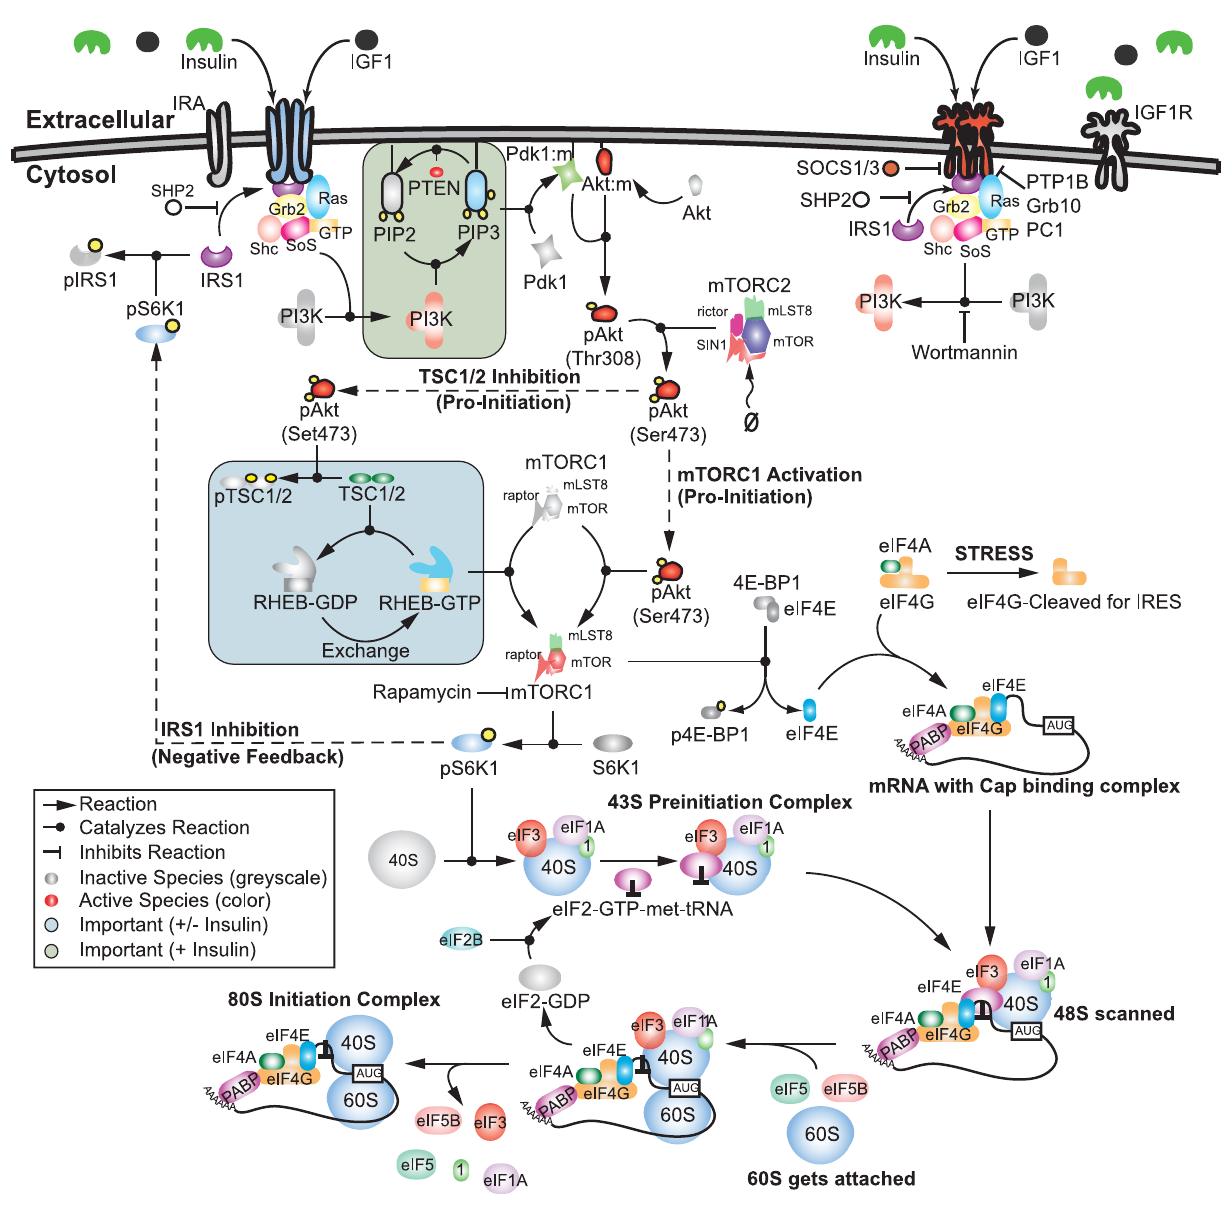
Figure 1. Schematic of the translation initiation signaling network. Growth factors trigger receptor dimerization and the formation of adaptor complexes which activate PI3K. PI3K then signals through PIP2/3 to activate Akt. Activated Akt can then activate mTORC1 either directly or by phosphorylating TSC1/2, an inhibitor of Rheb. Activated mTORC1 can phosphorylate 4EBP1 and activate S6K1, two necessary checkpoints for translation initiation. mTORC1 can also phosphorylate IRS-1, a negative feedback which inhibits formation of the adaptor complex and attenuates insulin signaling.